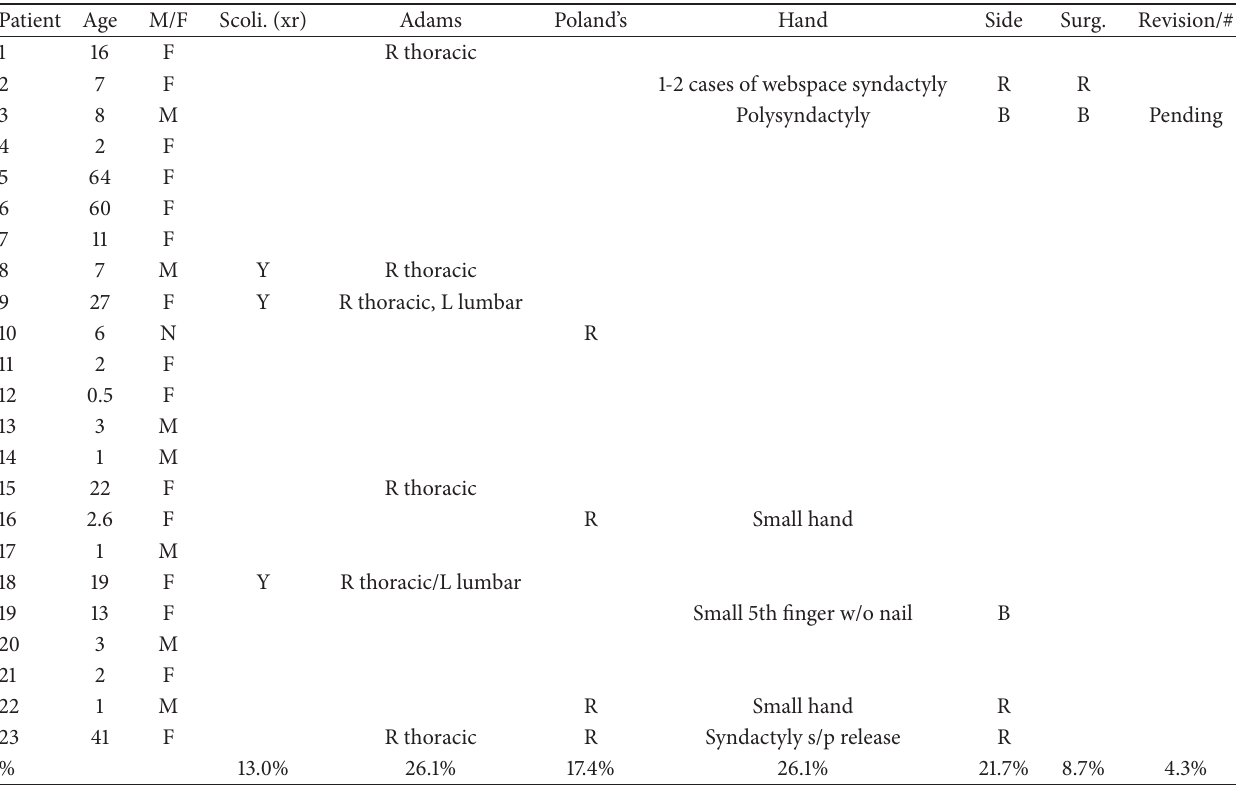
Table 2: Patient series contiued.